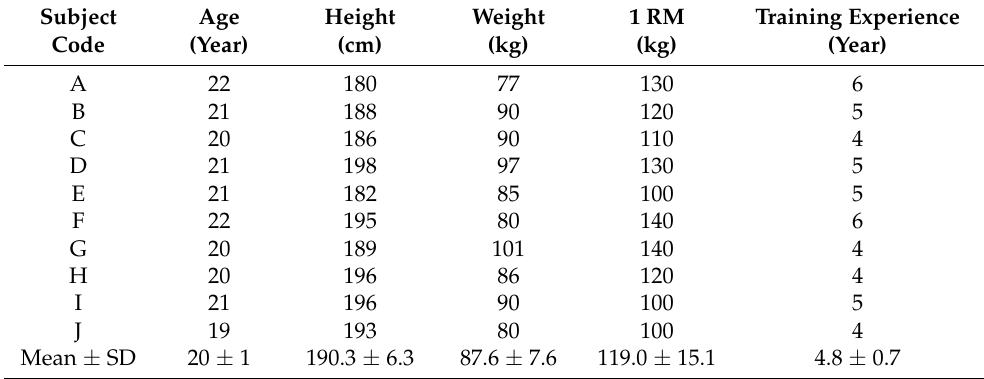
Table 1. Physical and physiological characteristics of